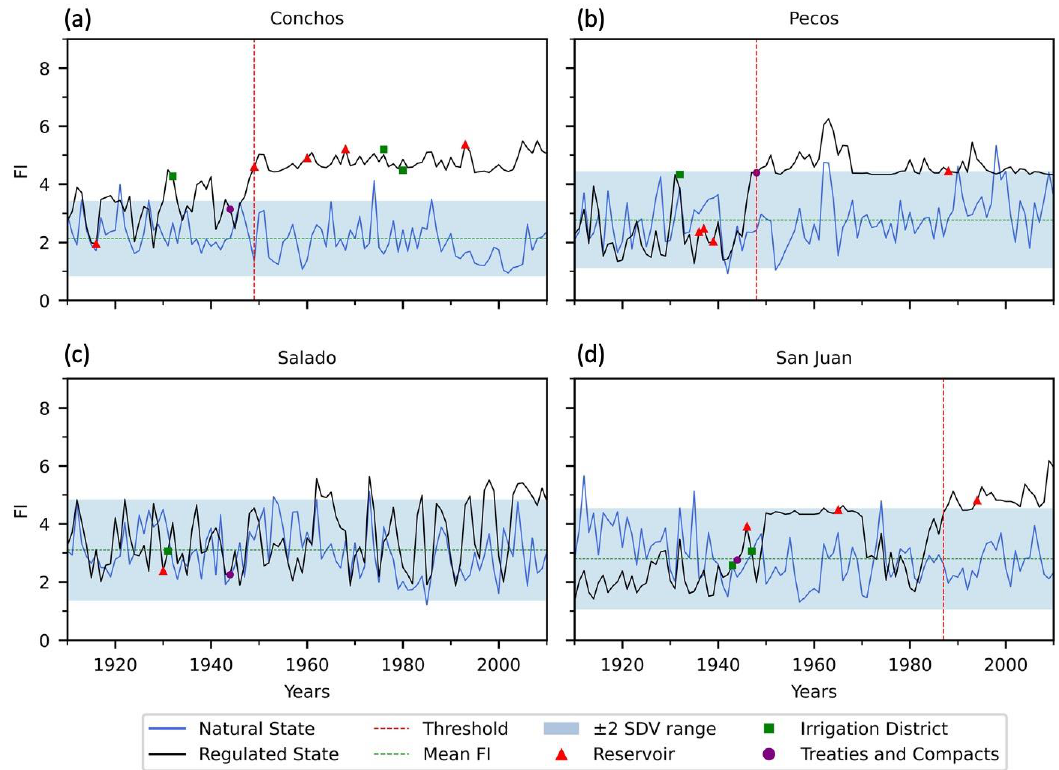
Figure 7. Analysis of regime shifts using Fisher Index (FI) in four sub-basins of the Rio Grande-Bravo basin including the control points of ( a ) Rio Conchos, ( b ) Pecos River, ( c ) Rio Salado, and ( d ) Rio San Juan. FI scores of the subfigures scores are shown for the natural (blue line) and regulated (black line) states, and the thresholds (dashed red line) indicate the year of a regime shift occurrence. The regulated state includes accumulated perturbations such as reservoirs, irrigation districts, and treaties and compacts. The ± 2 standard deviation (SDV) range (blue area) including the mean FI value (dashed green) indicate the baseline limits to detect regime